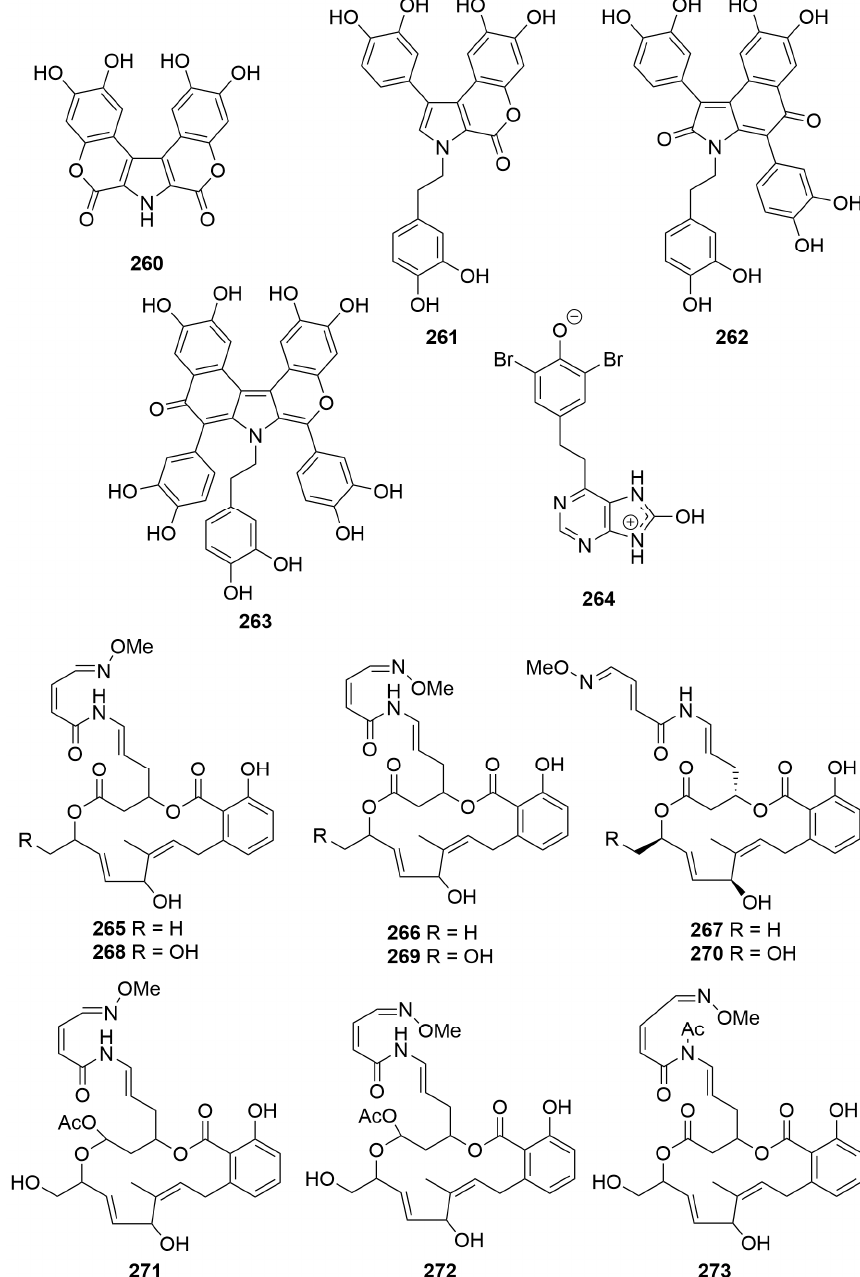
Figure 17. Compounds 260 to 273